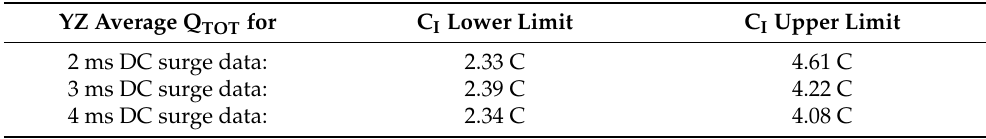
Table 7. Confidence interval limits of YZ average Q TOT .